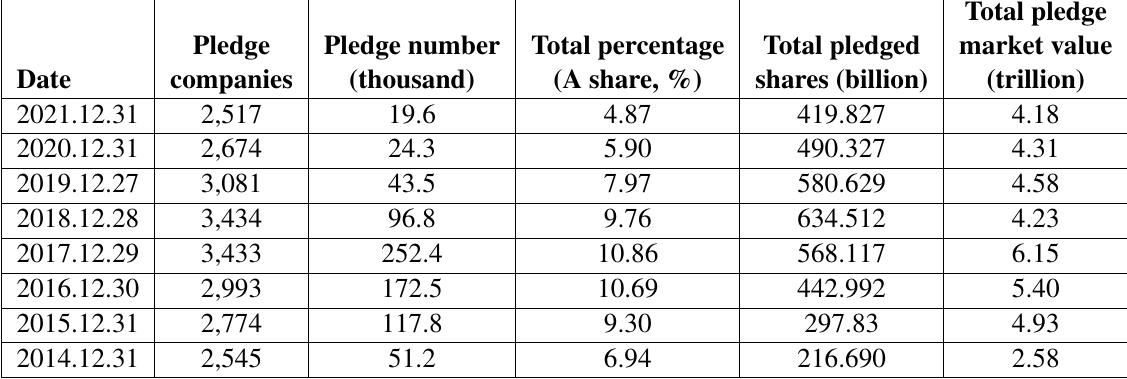
Table 1 Stock pledge of listed companies in China from 2014 to